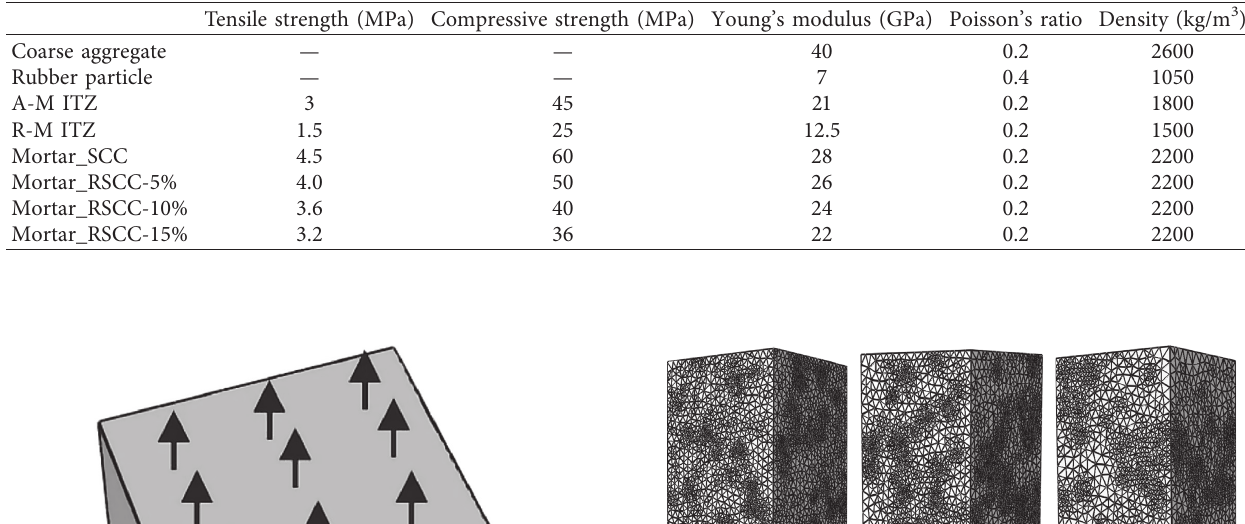
Table 3: Material parameters for the RSCC mesoscale model.